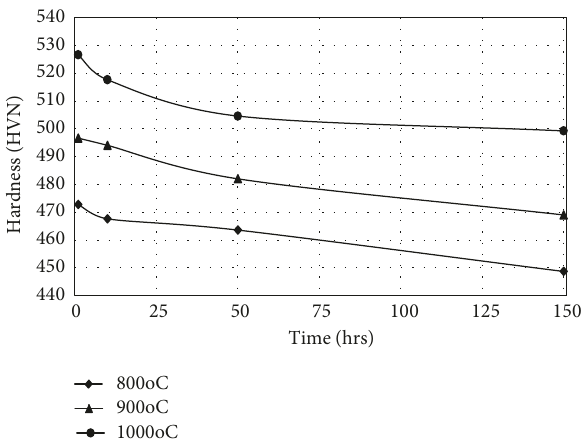
Figure 5: Hardness of the substrate in samples heated at different temperatures and